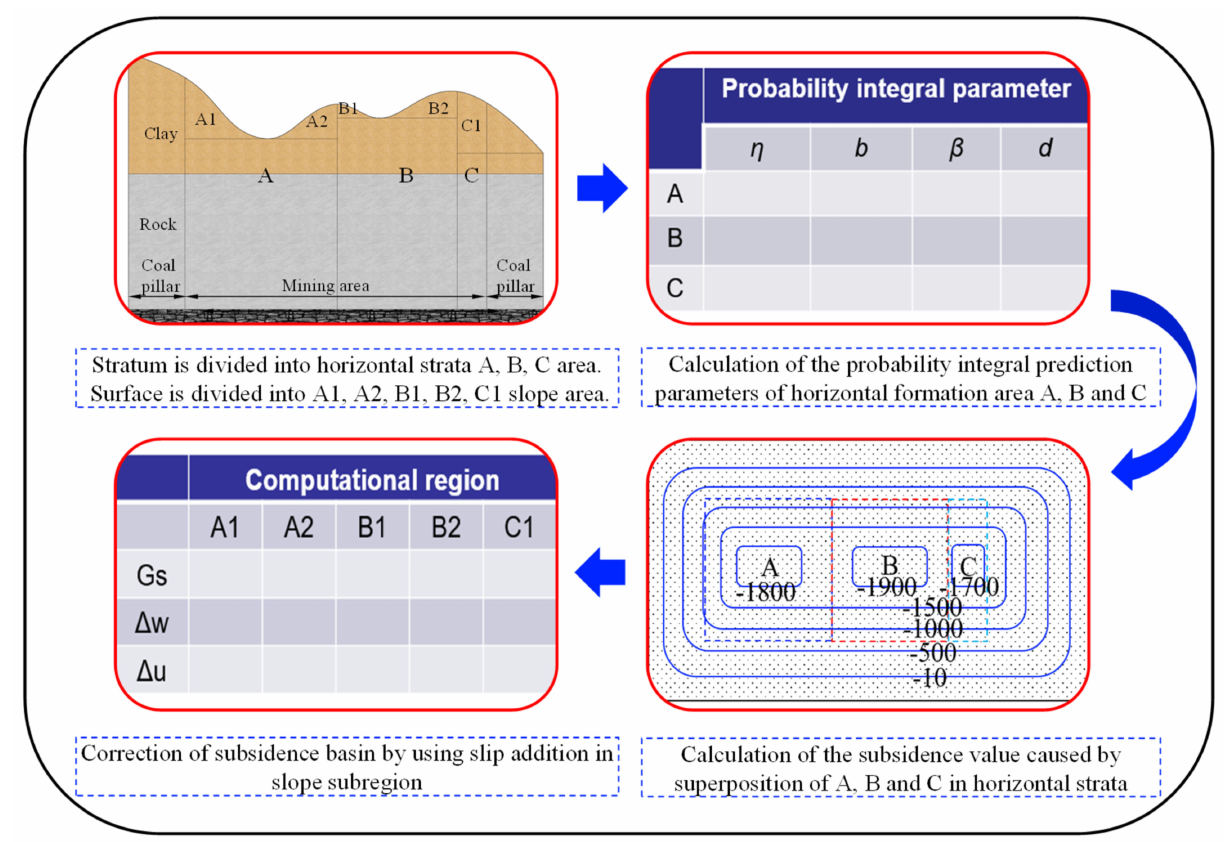
Figure 2. LDS application